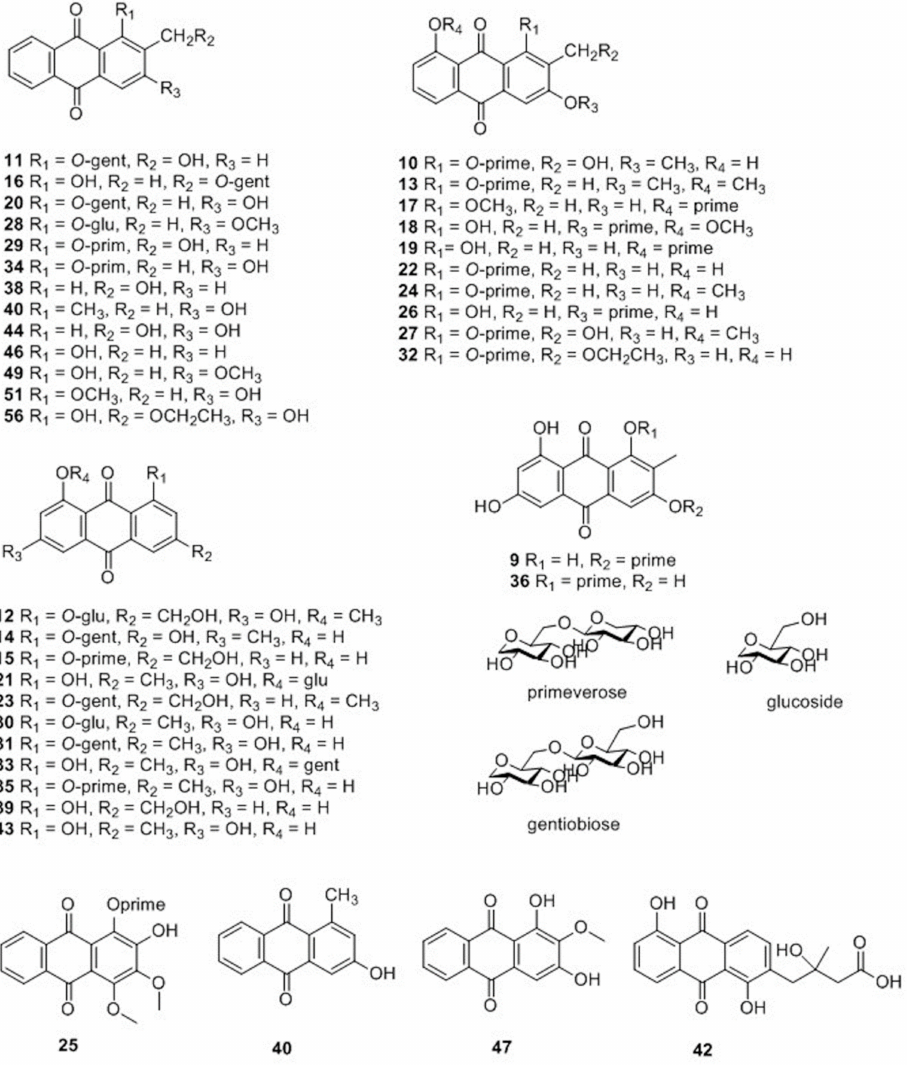
Figure 3. Chemical structures of anthraquinones identified in M. citrifolia and M. o ffi